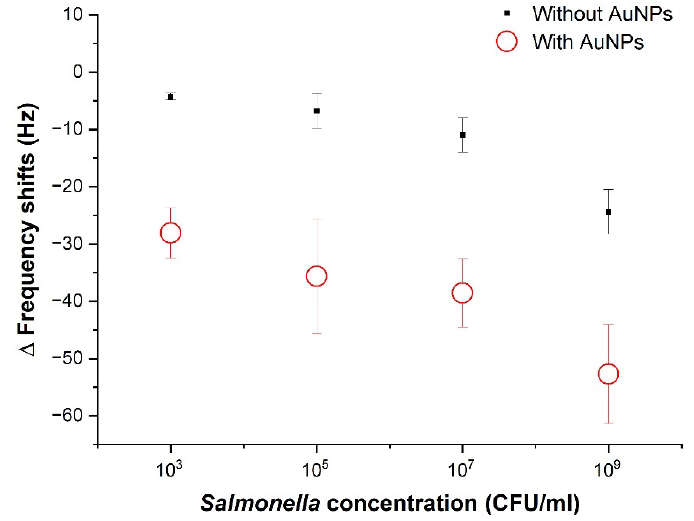
Figure 8. Comparisons of the average frequency shifts with and without AuNP attachment to the target bacterial cells ( n = 3). The black points indicate the average frequency shifts before and after Salmonella while the red points indicate the average frequency shifts before and after Salmonella and AuNPs. Table 1. Comparisons between Salmonella concentrations from plate counting method and frequency shifts data. The unit is Hz. SD represents standard deviation calculated based on Bessel’s